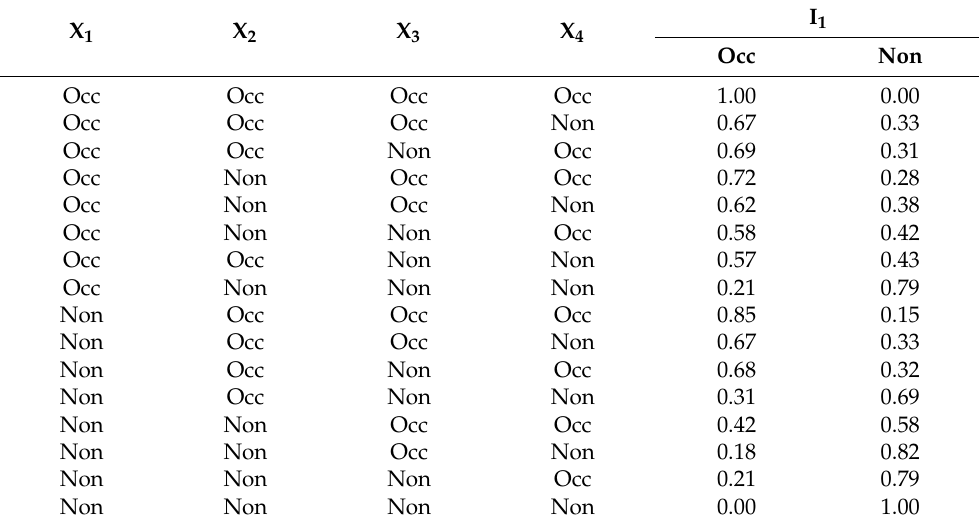
Table 16. The CPT of event I 1 in the BN model (Occ: occurred; Non: